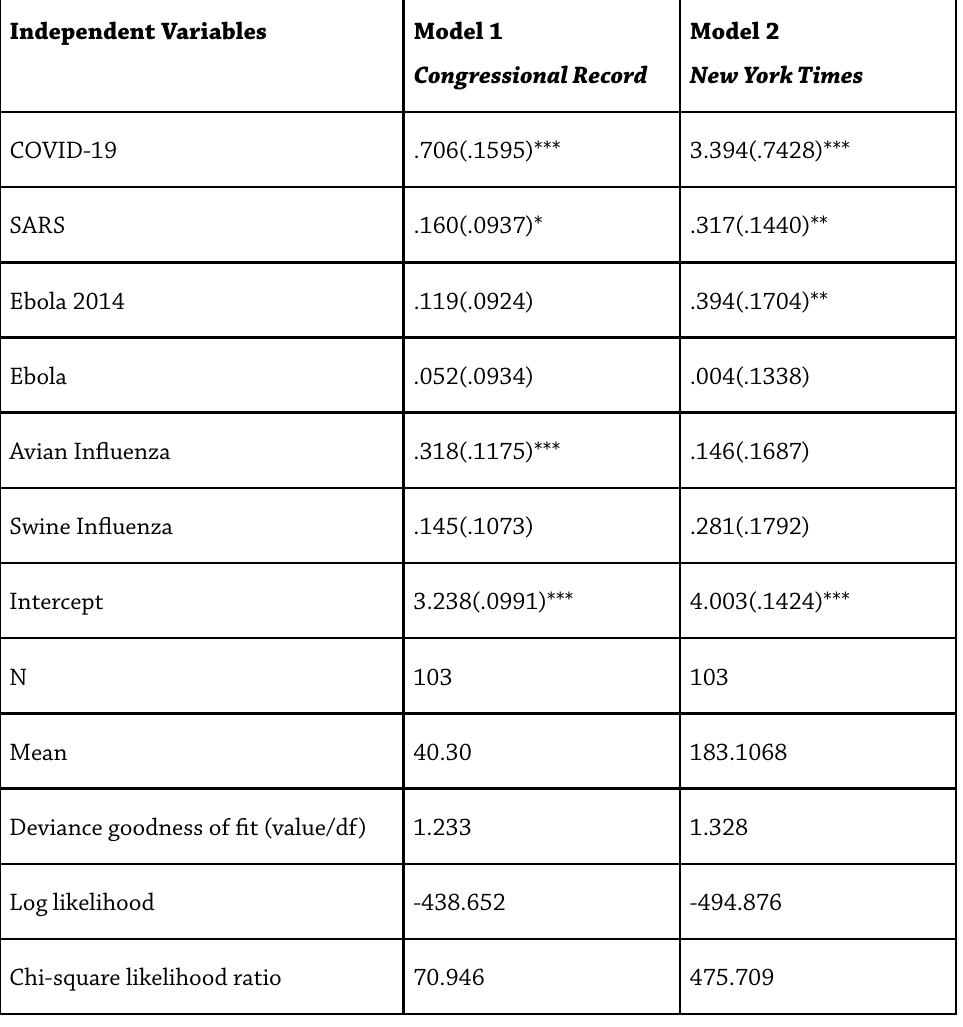
Table 2: Agenda Change and Novel Diseases Independent